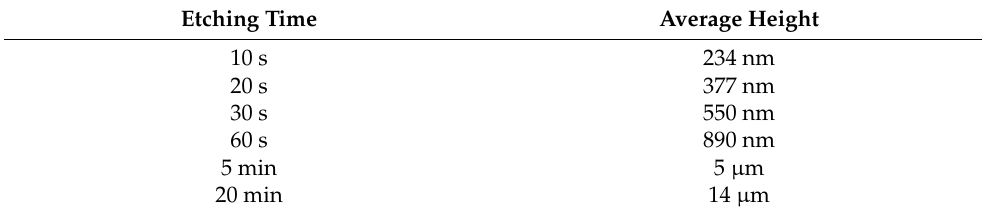
Table 1. The average wire height in relation to the etching time [34].